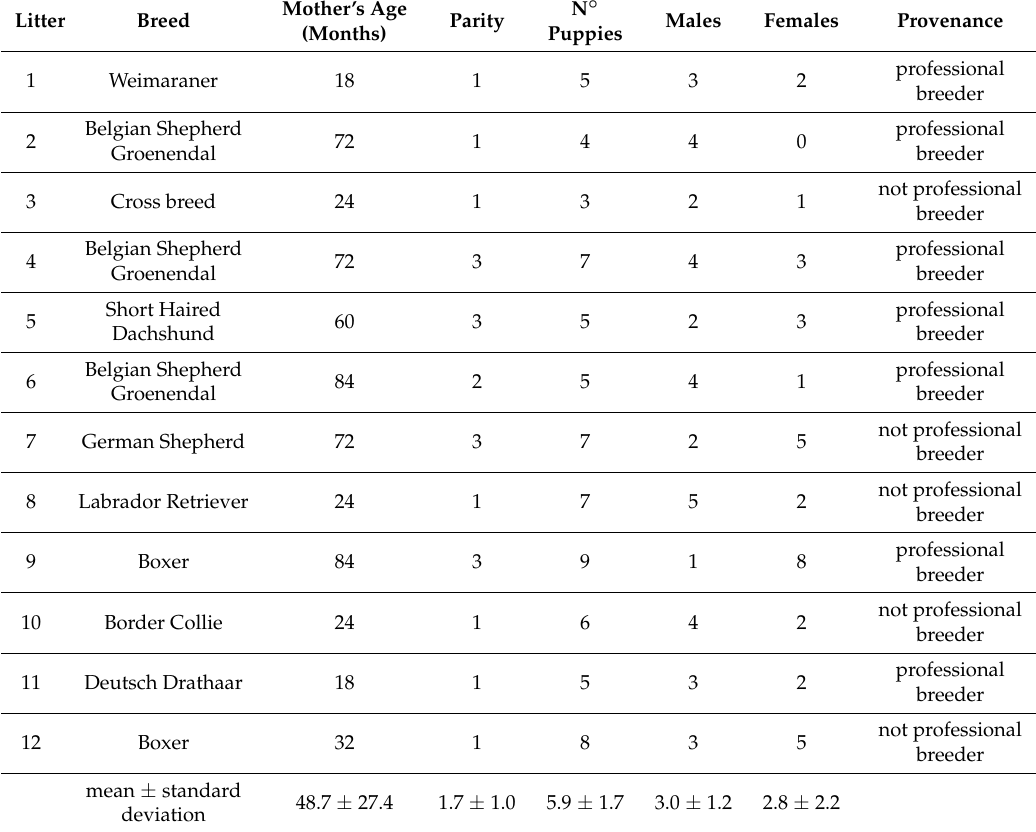
Table 1. Characteristics of the 12 litters included in the